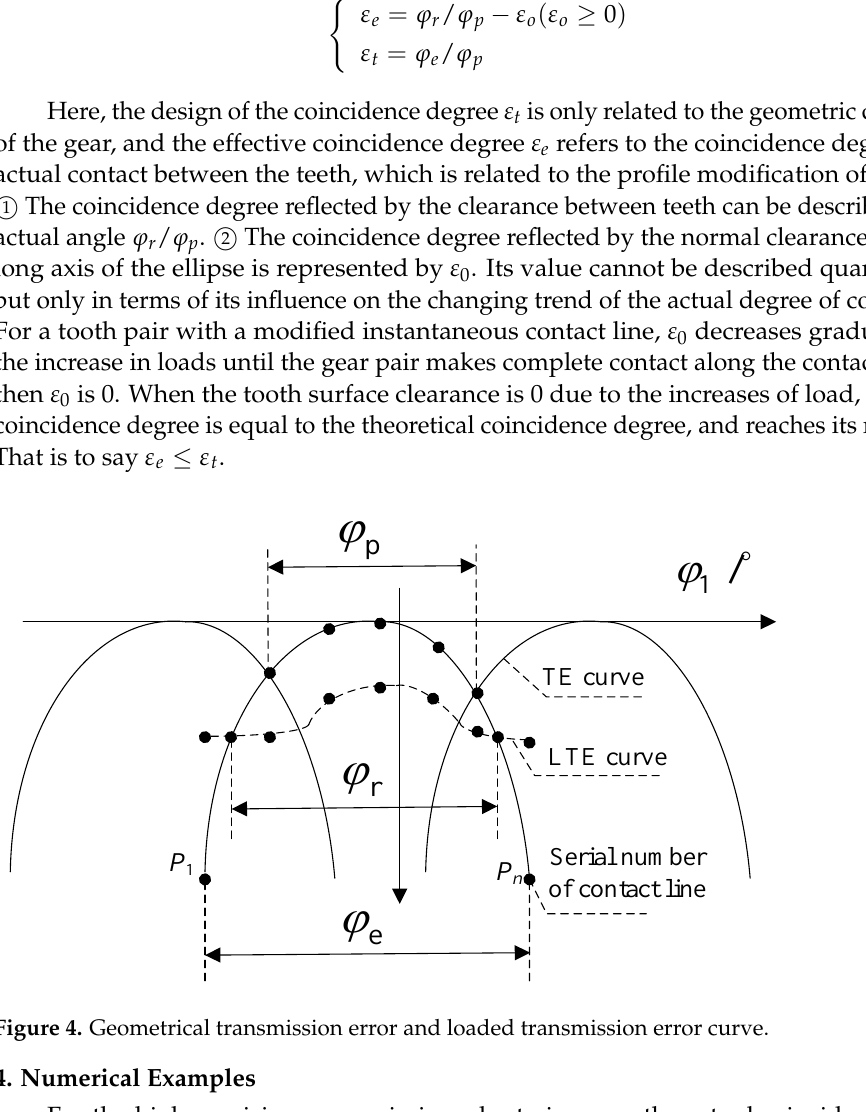
Table 1. Geometric parameters of the hypoid gear pair.